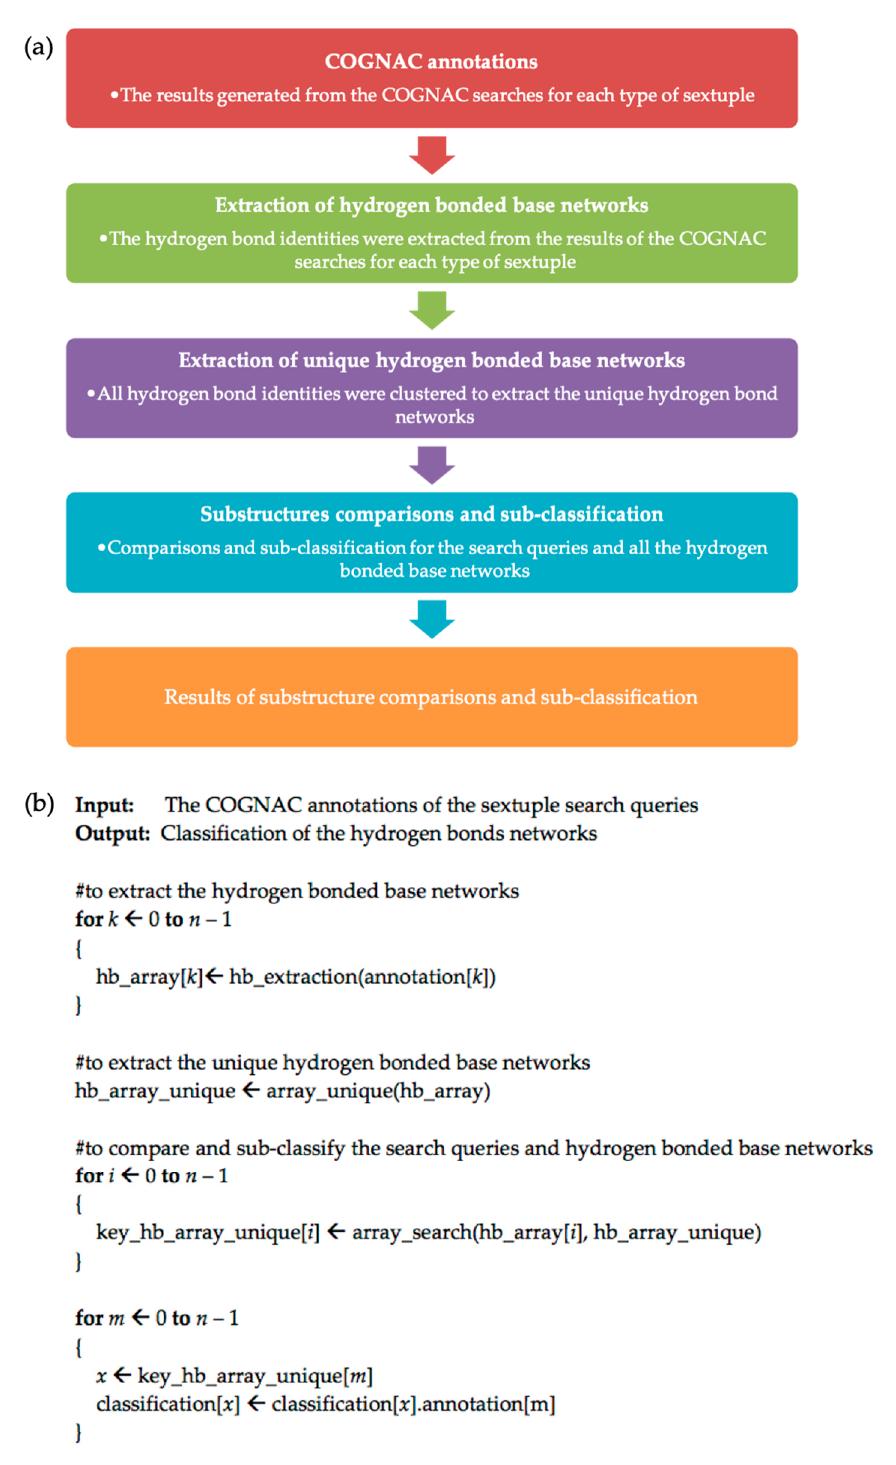
Figure 2. ( a ) Flowchart of the sextuple sub-classification method based on the identity of hydrogen bonding; ( b ) pseudo-code of the classification technique based on the identity of hydrogen bonding.